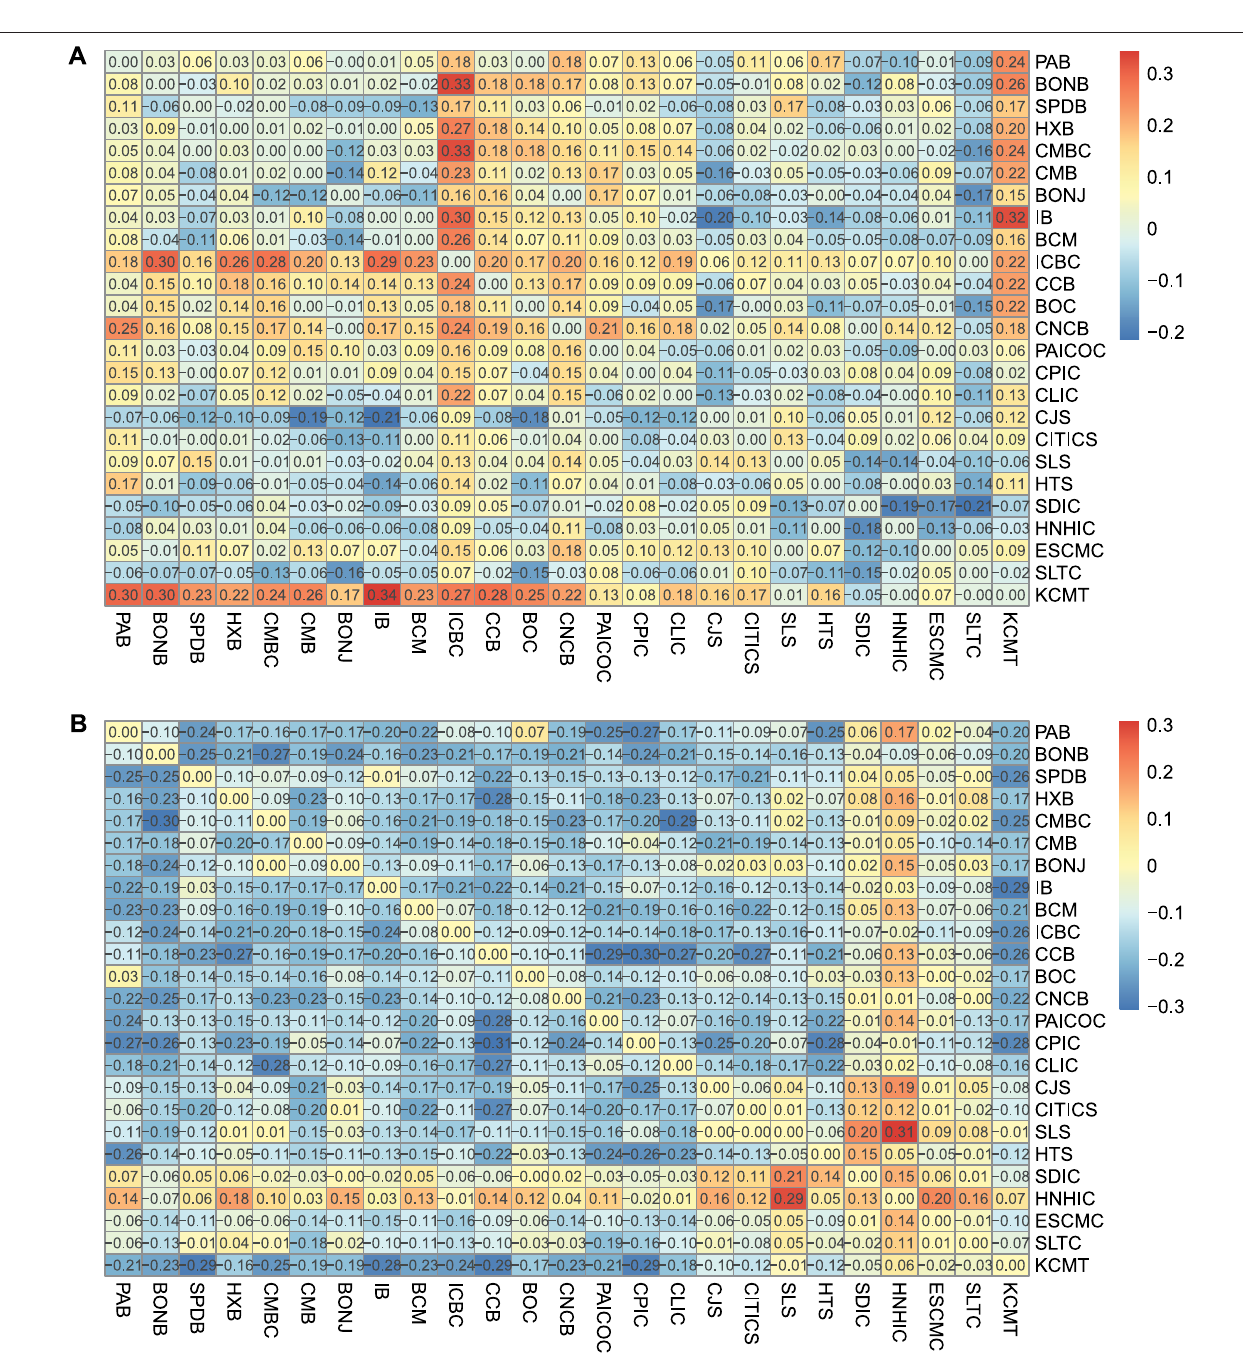
Frontiers in Physics |